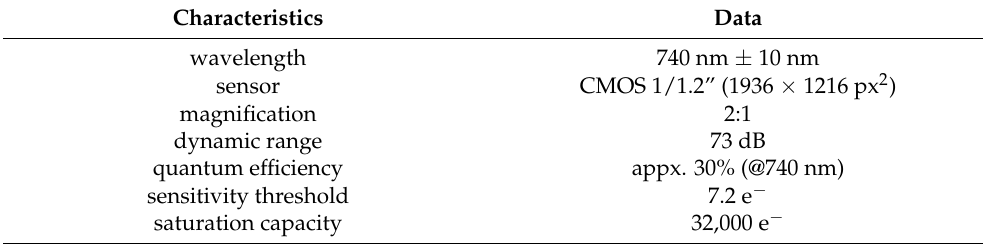
Table 2. Characteristics of the developed camera-based temperature measurement setup.